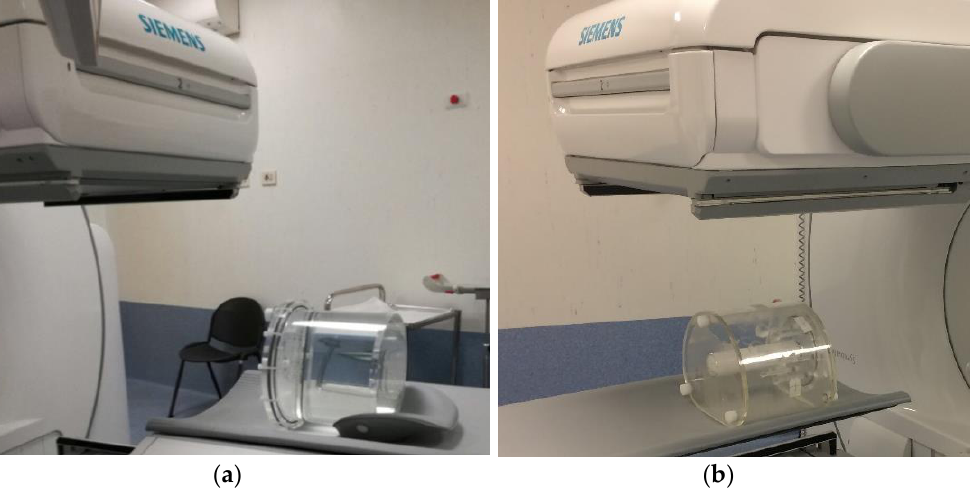
Figure 2. Data acquisition using the reference phantoms ( a ) homogeneous cylindrical and ( b ) the NEMA/IEC phantom.